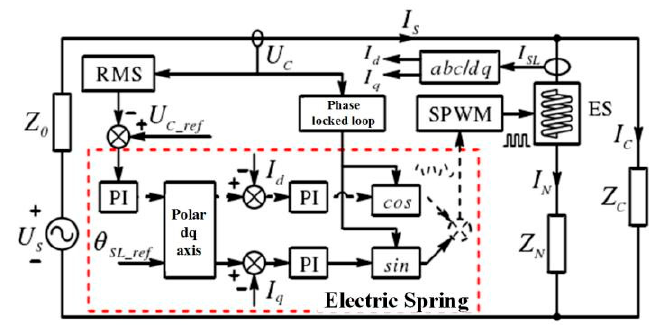
Figure 6. Three phase electric spring topology.